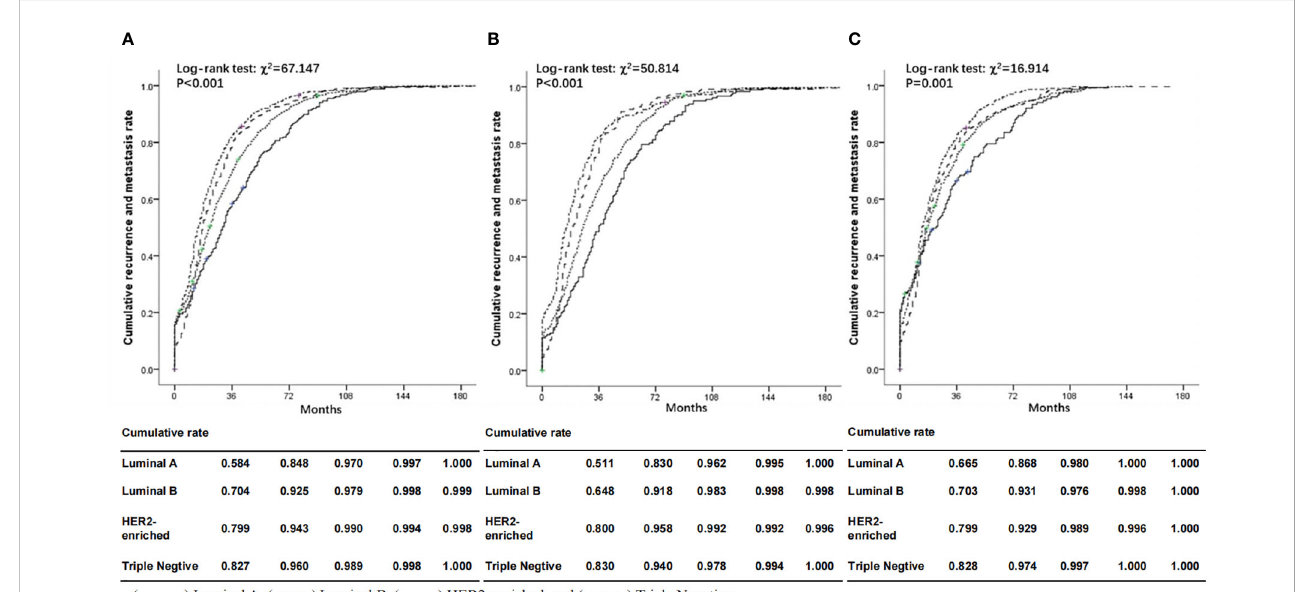
FIGURE 1 Comparisons of cumulative recurrence and metastasis rate according to molecular subtypes, overall (A) and in subgroups aged <45 (B) and ≥ 45 (C) at fi rst diagnosis. Solid lines represent ABC patients with Luminal A subtype; dotted lines represent ABC patients with Luminal B subtype; dashed lines represent ABC patients with HER2-enriched subtype; dash-dot lines represent ABC patients with Triple Negative subtype. () Luminal A, () Luminal B, () HER2-enriched and () Triple